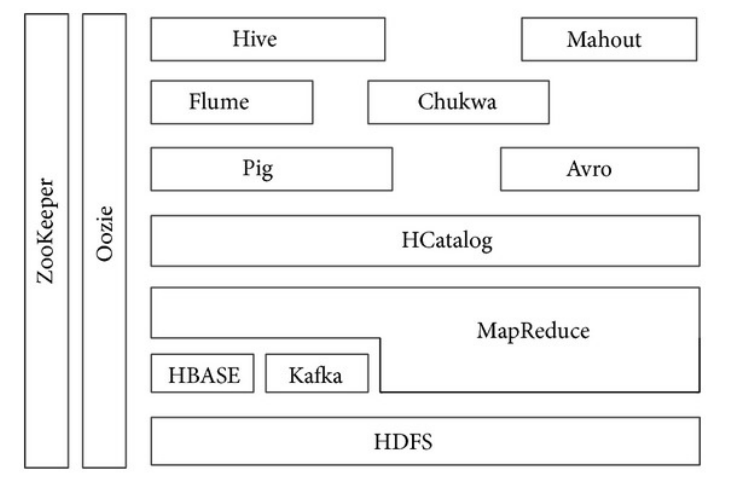
Figure 3. Hadoop ecosystem